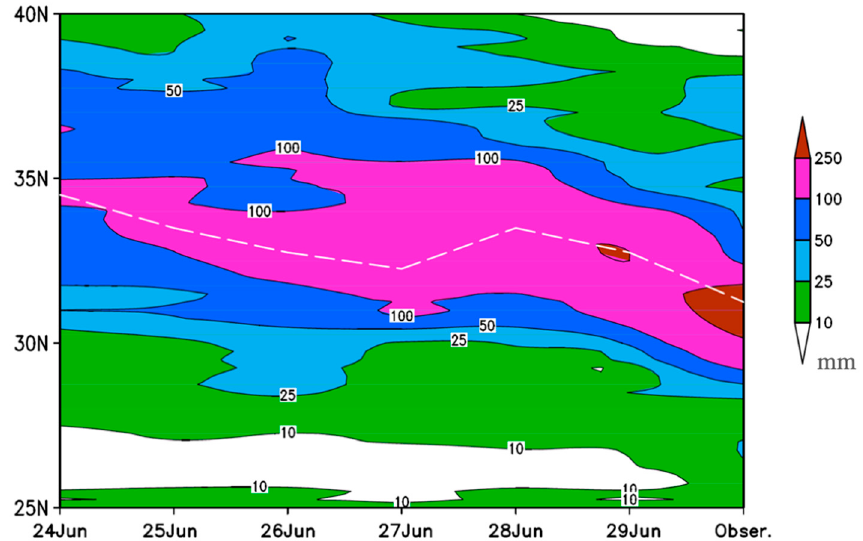
Figure 6. The zonal mean (110°–120° E) forecasted precipitation totals (mm) for the period of 0000 UTC 30 June to 0000 UTC 5 July 2016 from consecutive runs of the ECMWF deterministic forecast initialized from 1200 UTC 24 to 1200 UTC 29 June 2016. Observed zonal mean precipitation values for the event are shown on the right-most tick mark of the time axis. The dashed white line represents the zonal mean maximum accumulated precipitation (ZMCP).